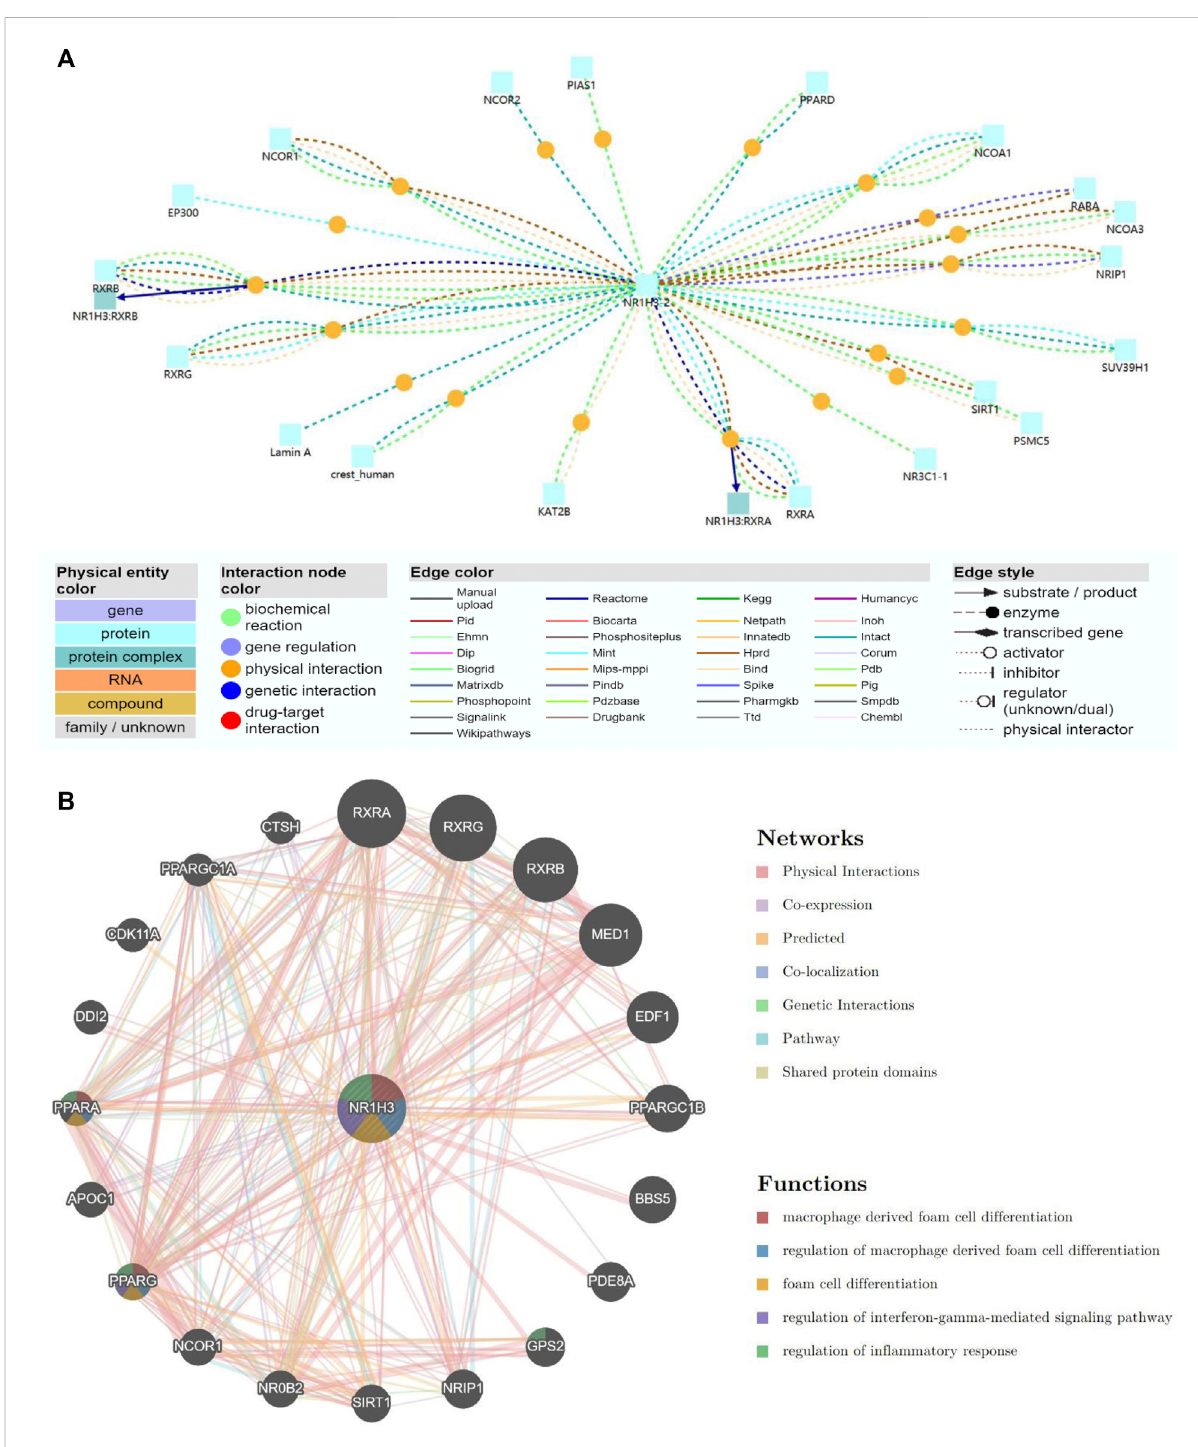
FIGURE 8 GeneinteractionnetworkofNR1H3. (A) ThegeneinteractionnetworkofNR1H3usingtheConsensusPathDBdatabase. (B) Thegeneinteraction network of NR1H3 constructed by the